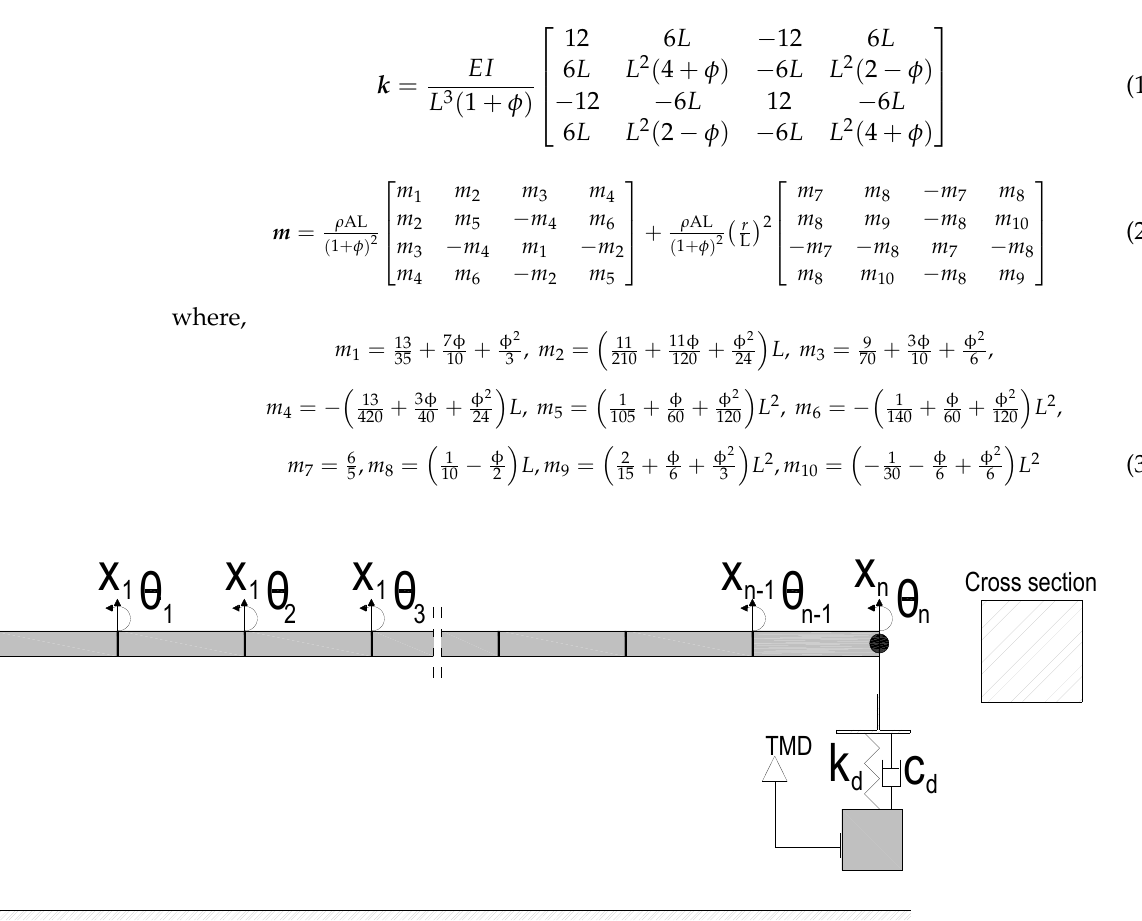
Figure 2. Cantilever beam–TMD model.